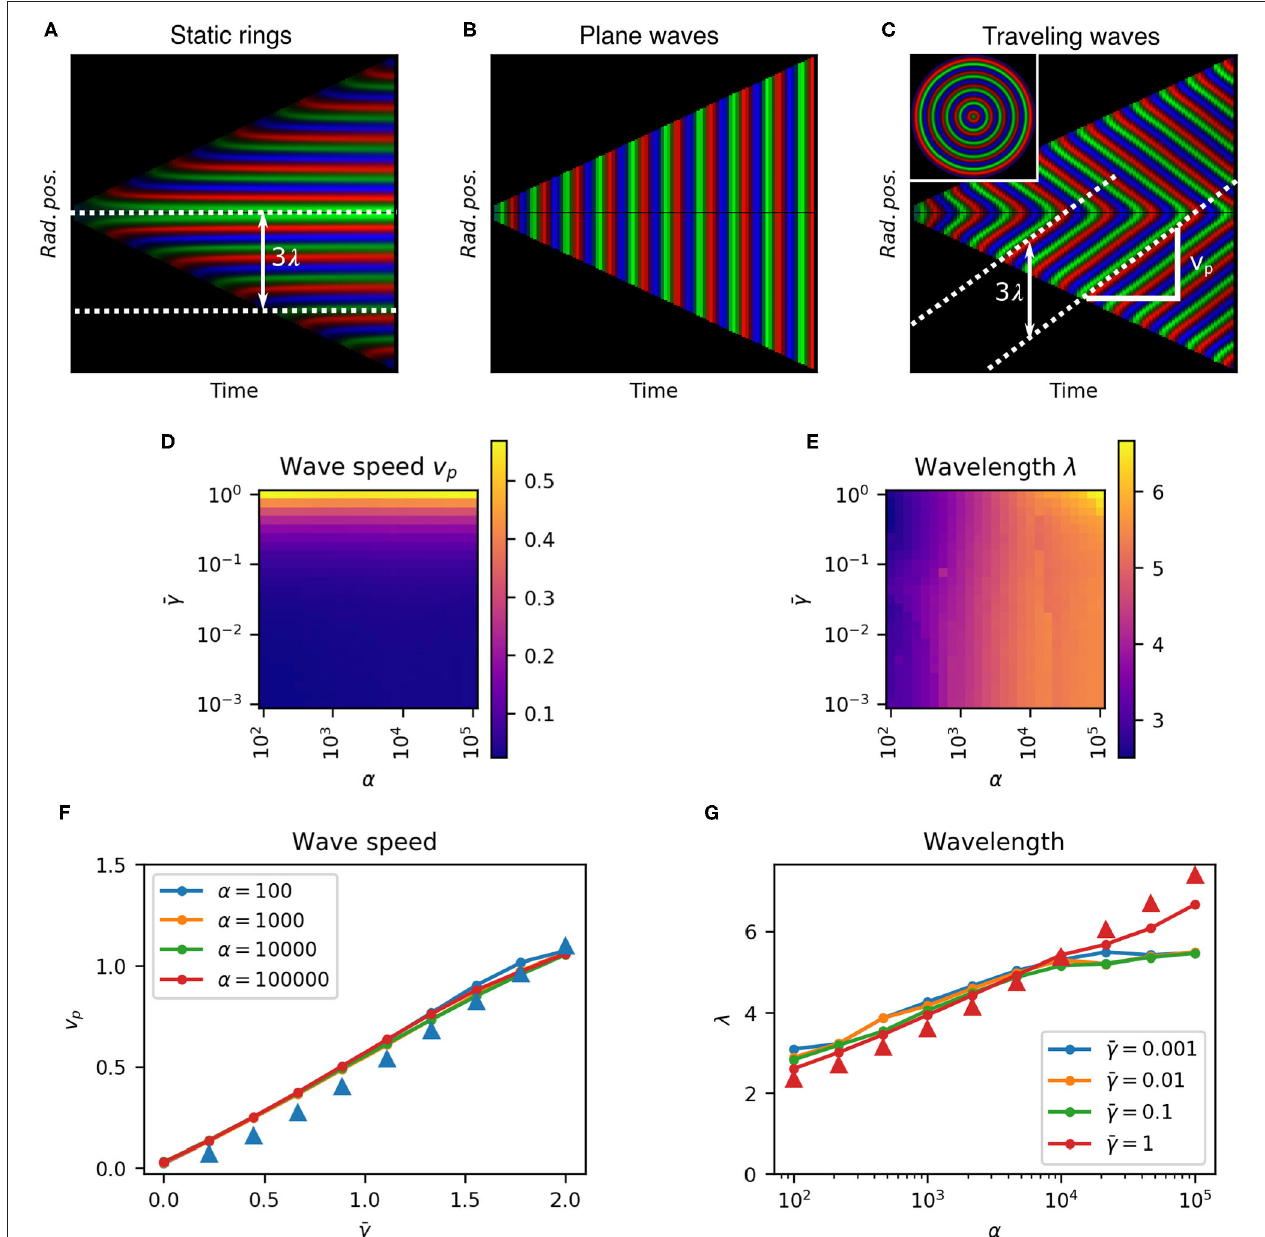
FIGURE 5 | Parameter dependence characterization for 1D model. (A–C) Kymographs of growing colonies show protein concentrations as a function of radial position over time, with no protein degradation ( A , ¯ γ = 0, α = 10 4 ) we obtain static rings, with no growth rate dilution ( B , ¯ γ = 1.5, α = 10 4 ) we see plane waves, and with growth rate dilution and protein degradation ( C , ¯ γ = 1.5, α = 10 4 ) we have traveling waves. White dashed lines show wave trajectories. The distance between two trajectories is the wavelength λ , and the slope is the wave speed v p . Inset in (C) is the whole colony at the end of the experiment. (D,E) . Heatmaps of wave speed v p and wavelength λ , respectively over a range of α and ¯ γ . (F) . Effect of ¯ γ on wave speed v p at different α . (G) . Effect of α on wavelength λ at different ¯ γ . Triangles in (F,G) show analytical estimates for α = 100 and ¯ γ = 1, respectively.